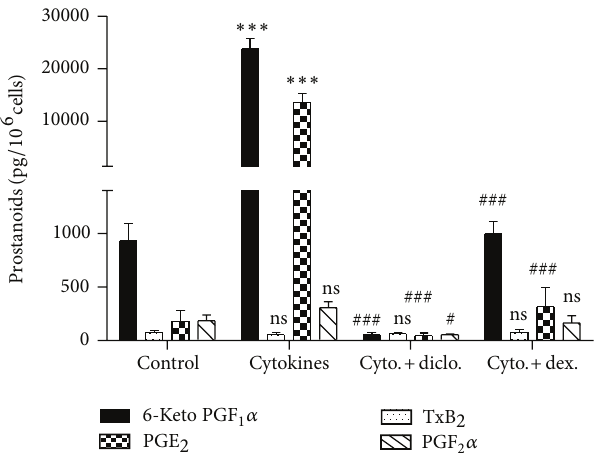
Figure 4: Pattern of COX1- and COX2-dependent prostanoid formation of human mesangial cells. HMCs were incubated for 20 h with cytokines in the absence or presence of diclofenac (1 𝜇 M),dexamethasone(1 𝜇 M),orvehicle.Prostanoidformationwas measured in the supernatant. Data represent means (pg/10 6 cells) ± SEM ( 𝑛 = 5 ). One-way analysis of variance Bonferroni’s multiple comparison test was performed for each product. ∗∗∗ 𝑃 < 0.001 versus control; ### 𝑃 < 0.001 and # 𝑃 < 0.05 versus cytokines; ns: